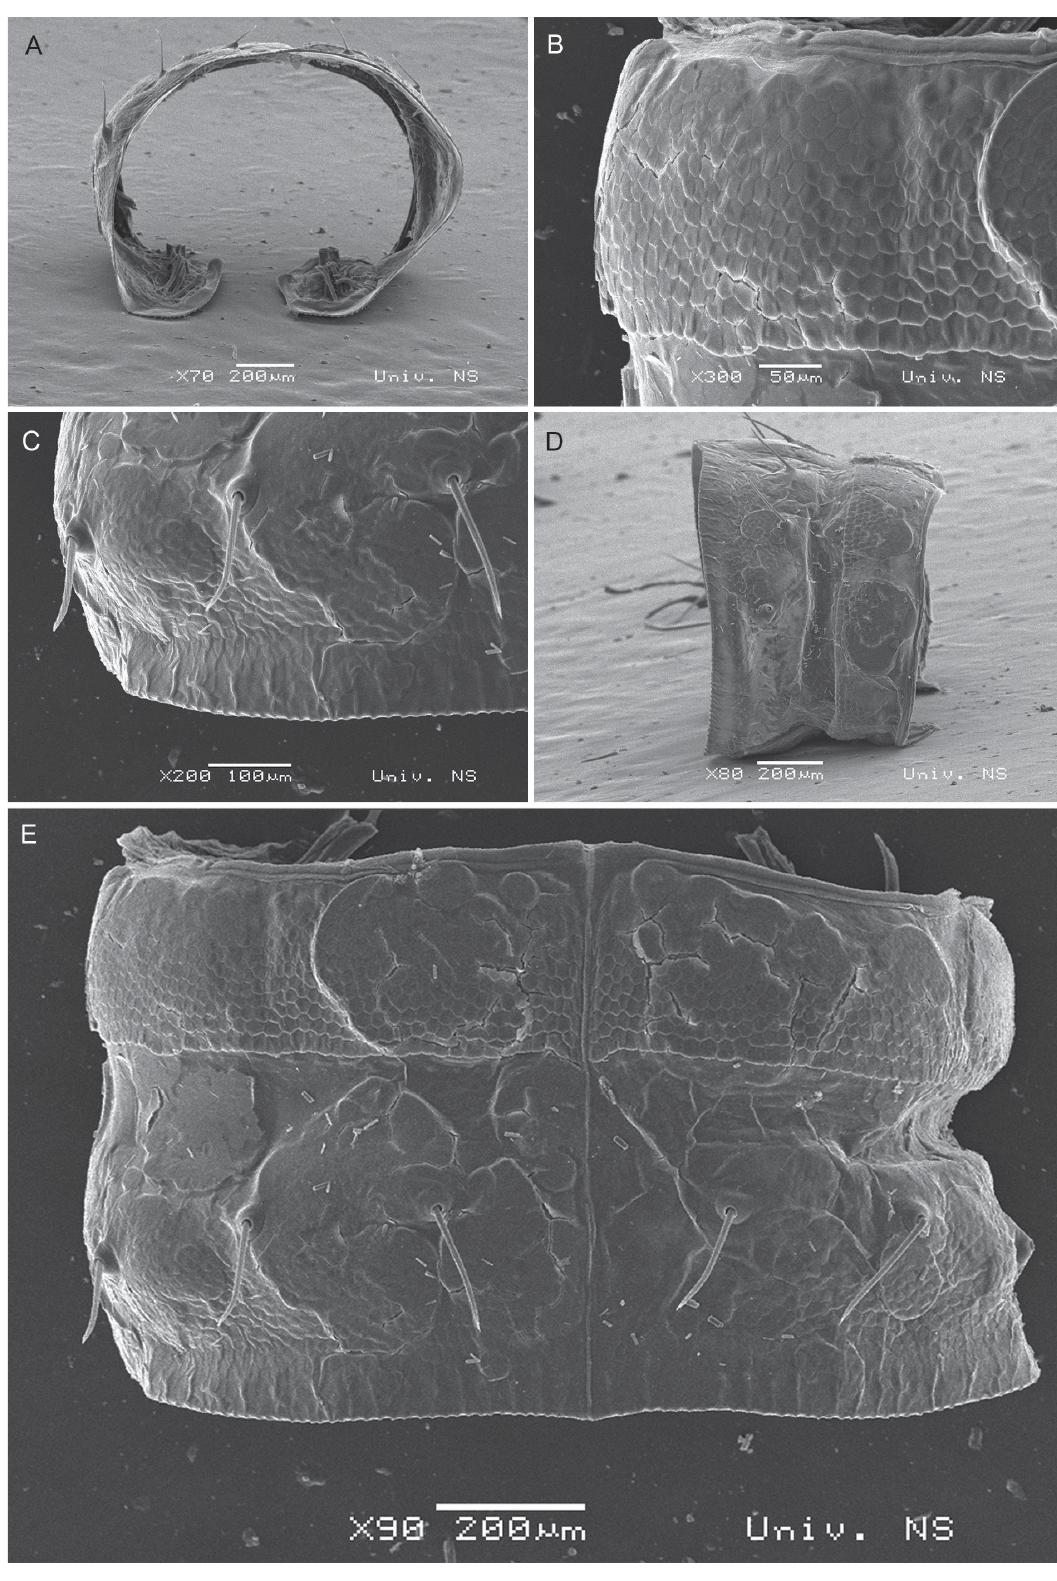
Fig. 1. Biokoviella mauriesi Mršić, 1992, ♂, topotype, pleurotergite 15. A . Posterior view. B . Prozonite, dorsal view. C . Metazonite, dorsal view. D . Lateral view. E .